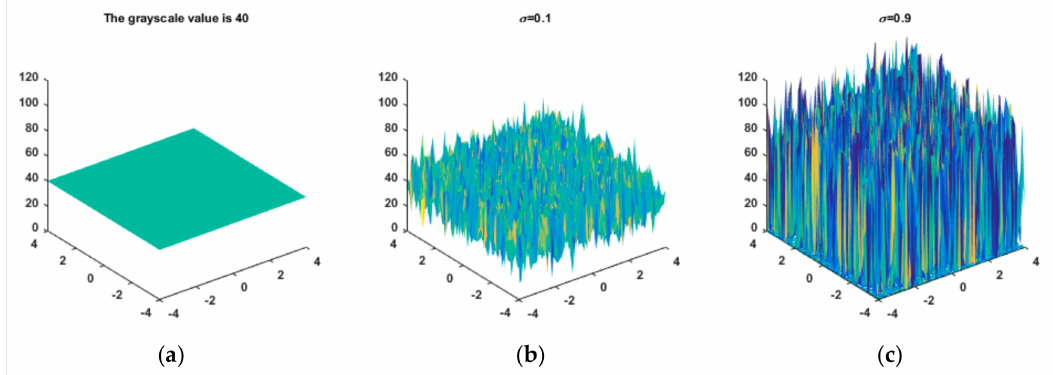
Figure 1. ( a ) The grayscale value is 40; ( b ) The e ff ects of speckle noise with variances of 0.1 on image gray values; ( c ) The e ff ects of speckle noise with variances of 0.9 on image gray